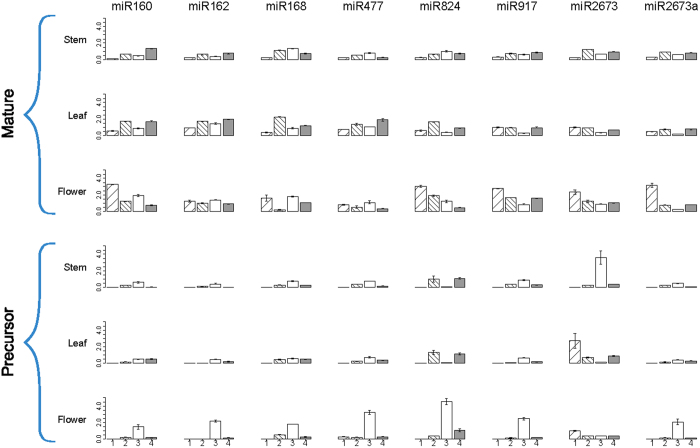
Expression of 8 microRNAs in three plant parts from 4 vendors.The first three rows show expression of mature microRNAs for stems, leaves and flowers in this order, while rows 4 to 6 show expression of precursor form of microRNAs for stems, leaves, and flowers in this order. Each column represents a different broccoli microRNA (all listed in the upper part of the figure). Each panel shows expression of a specific broccoli microRNA for a specific plant part from four different vendors (45° hash pattern bar vendor 1, 135° hash pattern bar vendor 2, white bar vendor 3 and gray bar vendor 4).